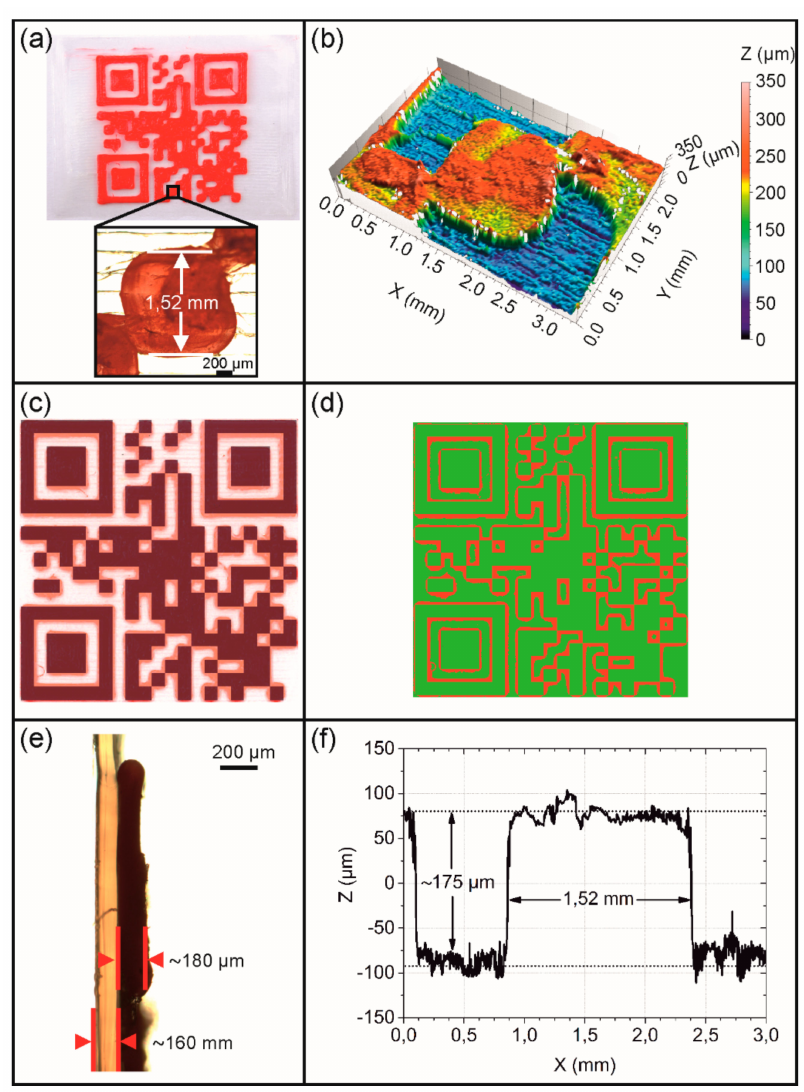
Figure 6. Type 2 QR code carrier as investigated by light and confocal microscopy including an evaluation of print quality: Top view and inset exhibiting a randomly selected cuboid ( a ), surface topography of the cuboid and its surrounding ( b ), superposition with a virtual QR code having a transparency of 60% ( c ), result of a mathematic calculation to determine the congruence of the virtual QR code with the physical print object: consistent print areas (green color) and irregularly filled areas (red color) ( d ), side view of a cut through the cuboid and the substrate ( e ), and the evolution of layer thickness Z with regard to the cuboid and its surrounding ( f